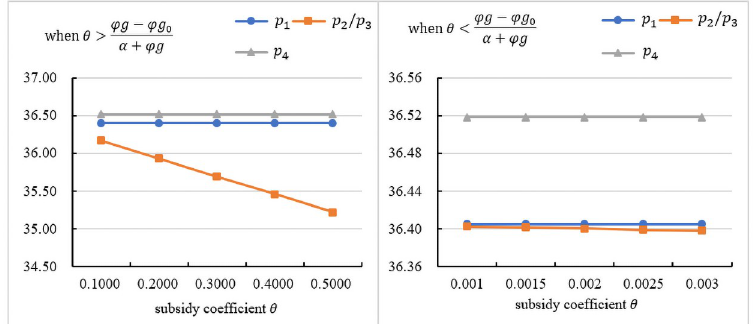
Fig 2. The influence of the subsidy coefficient on the retail